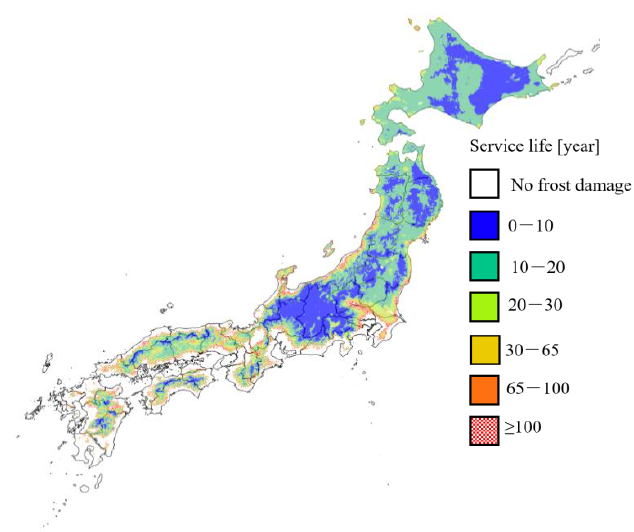
Figure 10. Distribution map of service life considering the effect of pore structure change due to drying with an initial durability factor of 60. Solar radiation conditions: north side; curing conditions: 20 °C drying; freezing and thawing conditions: thawing in air; and water-to-cement ratio: 0.45.